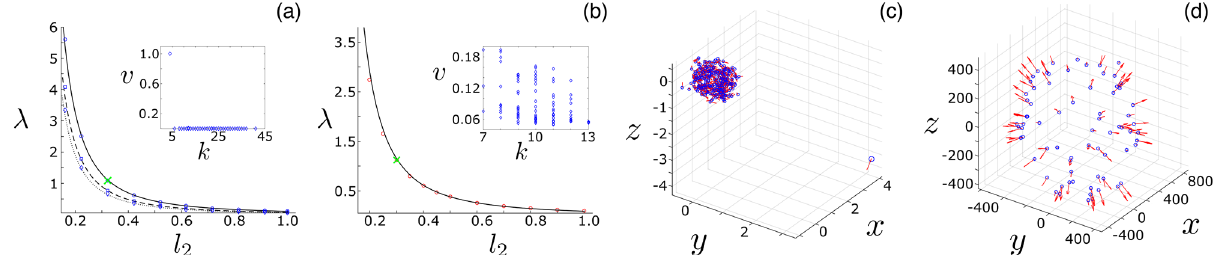
Figure 4. Shedding of agents from milling states. ( a ) Critical coupling for localized shedding in a Waxman geometric random graph. Points indicate simulation-determined values while lines indicate mean-field predictions. Plotted are the first three shedding transitions: k = 4 (circles, solid line), k = 6 (squares, dashed line), and k = 8 (diamonds, dotted line). ( b ) Critical coupling for the single, delocalized shedding transition in a Watts–Strogatz random graph. The Watts–Strogatz graph was composed of 100 agents with an average degree of 10. Inlet panels in ( a ) and ( b ) show the predicted unstable mode associated with the upper mean-field bifurcation by solving Eq. (6). Example snapshots for (cid:31) just below the respective transitions are shown in ( c ) and ( d ) for the two graphs. Locations for the snapshots within the diagrams ( a ) and ( b ) are specified with a green x. Other model parameters and plotting conventions are identical to Fig.